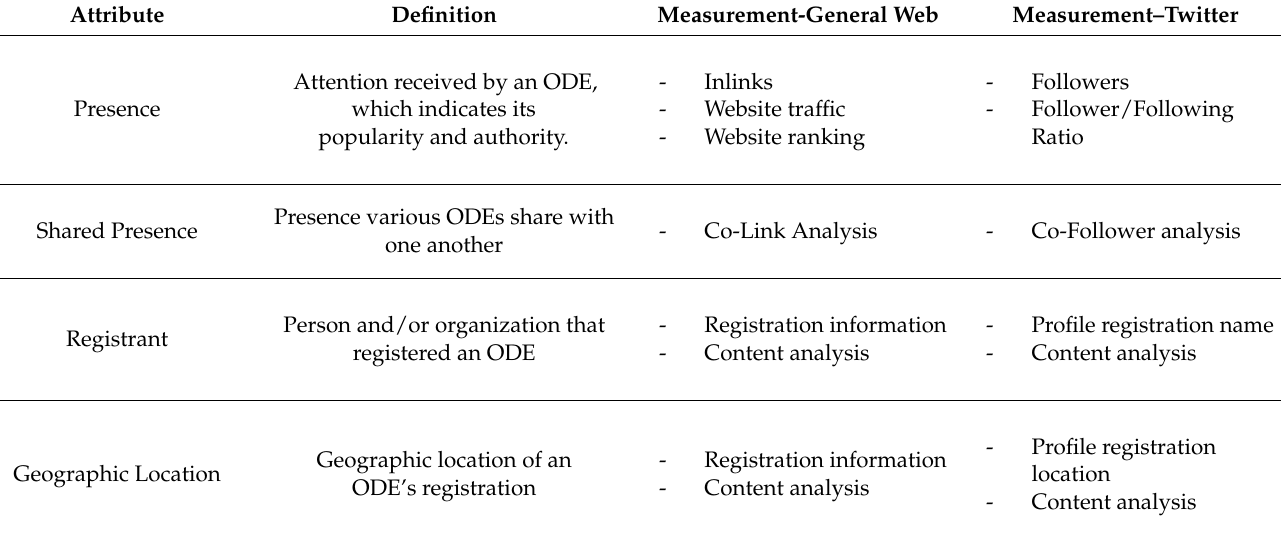
Table 1. Attributes of